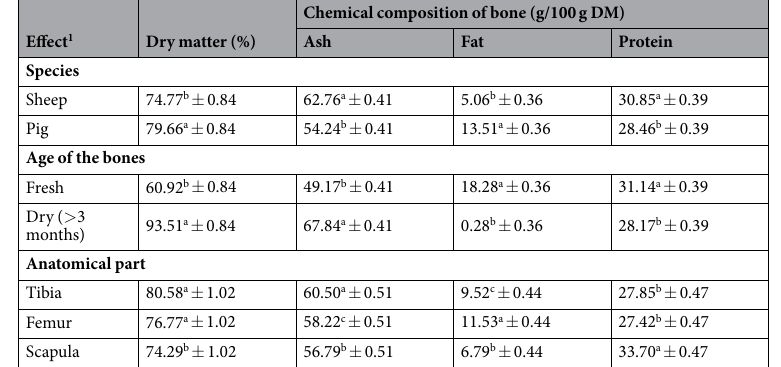
Table 1. Chemical composition of bone according to species, preservation time and anatomical part (Mean ± s.e.). 1 Species and Anatomical part effect calculated using fresh and dry bones. Age of the bones effect calculated using both species. Different superscripts indicate significant differences between values (p <